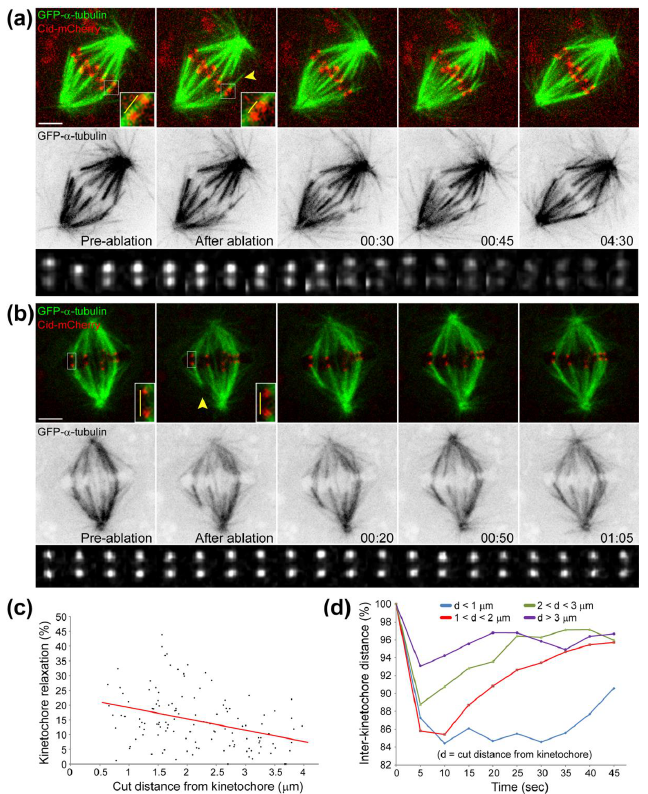
Figure 6. Forces at kinetochores are proportional with k-fiber length, but chromosome position at the equator is independent of k-fiber length. ( a , b ) Laser microsurgery of k-fibers in Drosophila S2 cells stably expressing GFP- α -tubulin to label microtubules (green) and Cid-mCherry to label kinetochores (red). K-fibers were cut (yellow arrowhead) and grew back as described previously [29]. Inverted contrast of GFP- α -tubulin is also shown, as well as the variation of inter-kinetochore distance over time (kymograph; first frame corresponds to pre-surgery distance; second frame onwards are after surgery). Measurement of the inter-kinetochore distance before and after laser surgery ablation of k-fibers (yellow bars) indicates that kinetochores relax after surgery, and this relaxation is more evident the closer the cut is to the kinetochore. Time is in min:sec. White scale bars are 2 µ m; ( c ) Quantification of the percentage of kinetochore relaxation after surgery (determined by the difference between initial inter-kinetochore distance and the minimum observed distance after surgery) indicates a negative correlation (R 2 = − 0.361; p < 0.001) with the cut distance from the kinetochore (n = 125 cells); ( d ) Corresponding quantification of the inter-kinetochore distance over time as a function of the cut distance from the kinetochore. Each group was normalized against its initial distance such that one hundred percent corresponds to the average initial distance. The closer the cut is to the kinetochore, the longer the recovery of inter-kinetochore distance and the higher is the relaxation. The inclusion of a kinetochore marker in this study and the observed variability of inter-kinetochore distance after k-fiber cut explains previous observations in which no detectable kinetochore relaxation was observed without the use of a kinetochore marker [29]. Laser microsurgery was performed essentially as described in